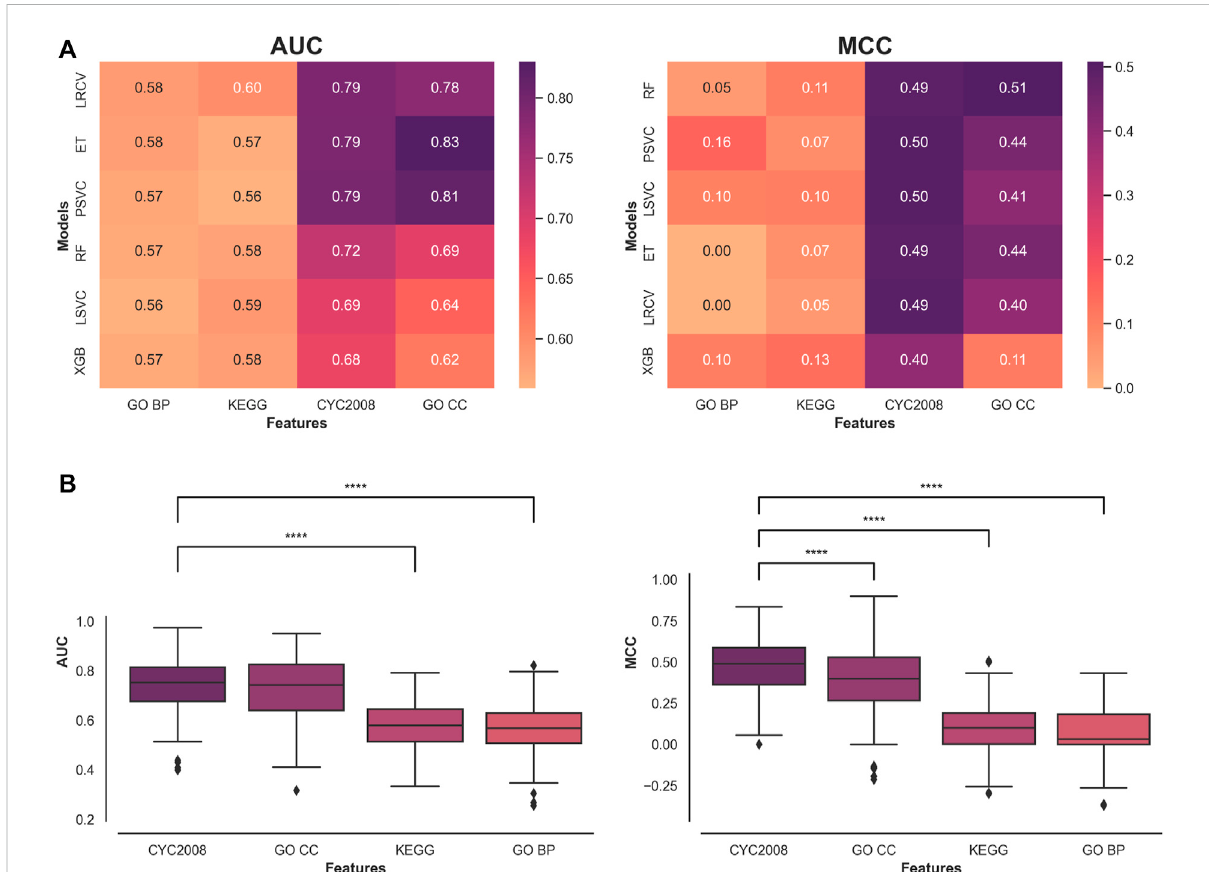
FIGURE 1 Comparative assessment of feature set performance in classifying short and long phenotypes. (A) Median model performance for each feature set. (B) PerformancedistributionofthefeatureswithaMann-WhitneyUtestwithcontinuitycorrectioncomparingthetopfeaturesetwithalltherest with the signi fi cant comparisons indicated. **** indicates p <